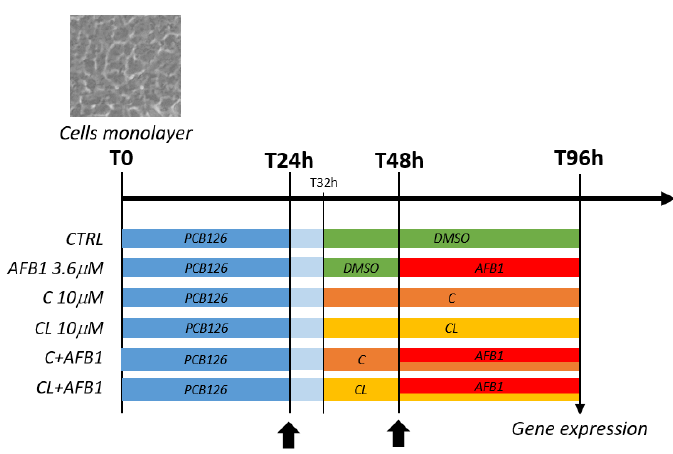
Figure 1. Summary of cell treatments. Scheme reporting the cell treatments performed in this study and the resulting experimental groups assayed with the RNA-seq approach. C = curcumin; CL = Curcuma longa . Arrows indicate complete medium changes (fresh medium and treatment solutions).